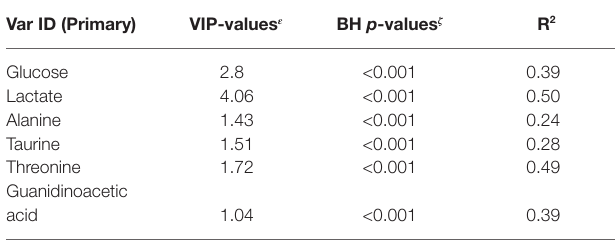
TABLE 4 | List of the 6 biomarkers of foie gras technological yield identified with the metabolite method. Var ID